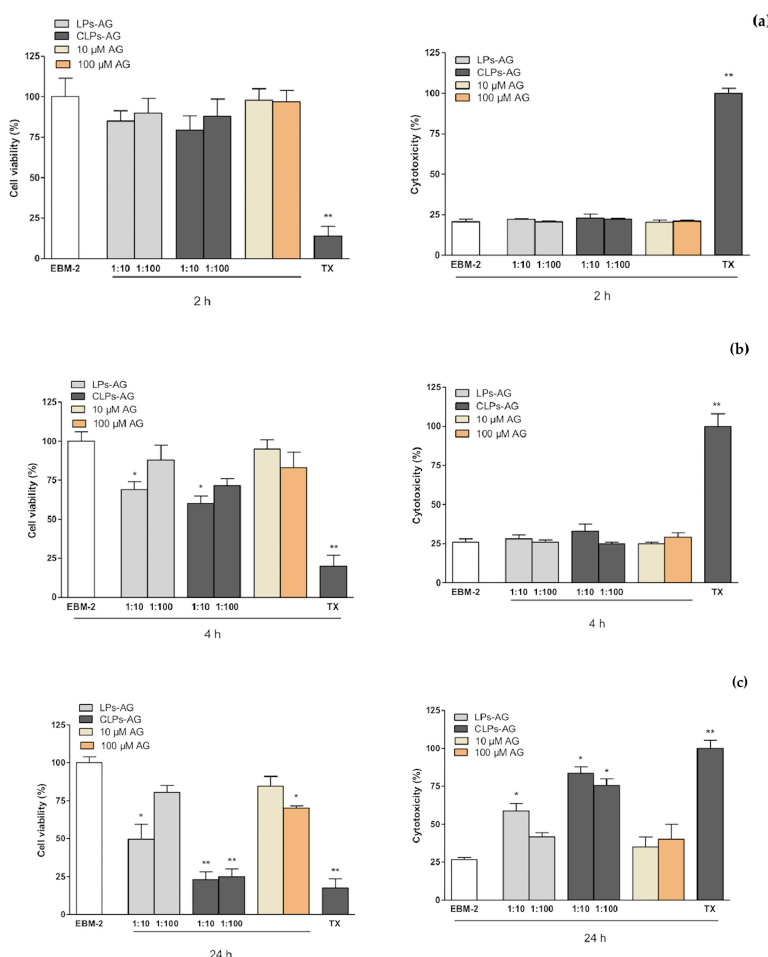
Figure 4. hCMEC/D3 cell viability evaluated by MTT assay (left panel) and cytotoxicity by LDH assay (right panel) when exposed for 2 h ( a ), 4 h ( b ) and 24 h ( c ) to AG (10 and 100 µ M) or LPs-AG and CLPs-AG (0.0085 and 0.085 mg/mL). Data is expressed as percentage of control (EBM-2 medium) and Triton-X (TTX) which represent, respectively, the maximum cell viability and cell cytotoxicity. Values represent the mean ± SEM of at least three experiments performed in triplicate. * p < 0.05 and ** p < 0.01 vs. EBM-2